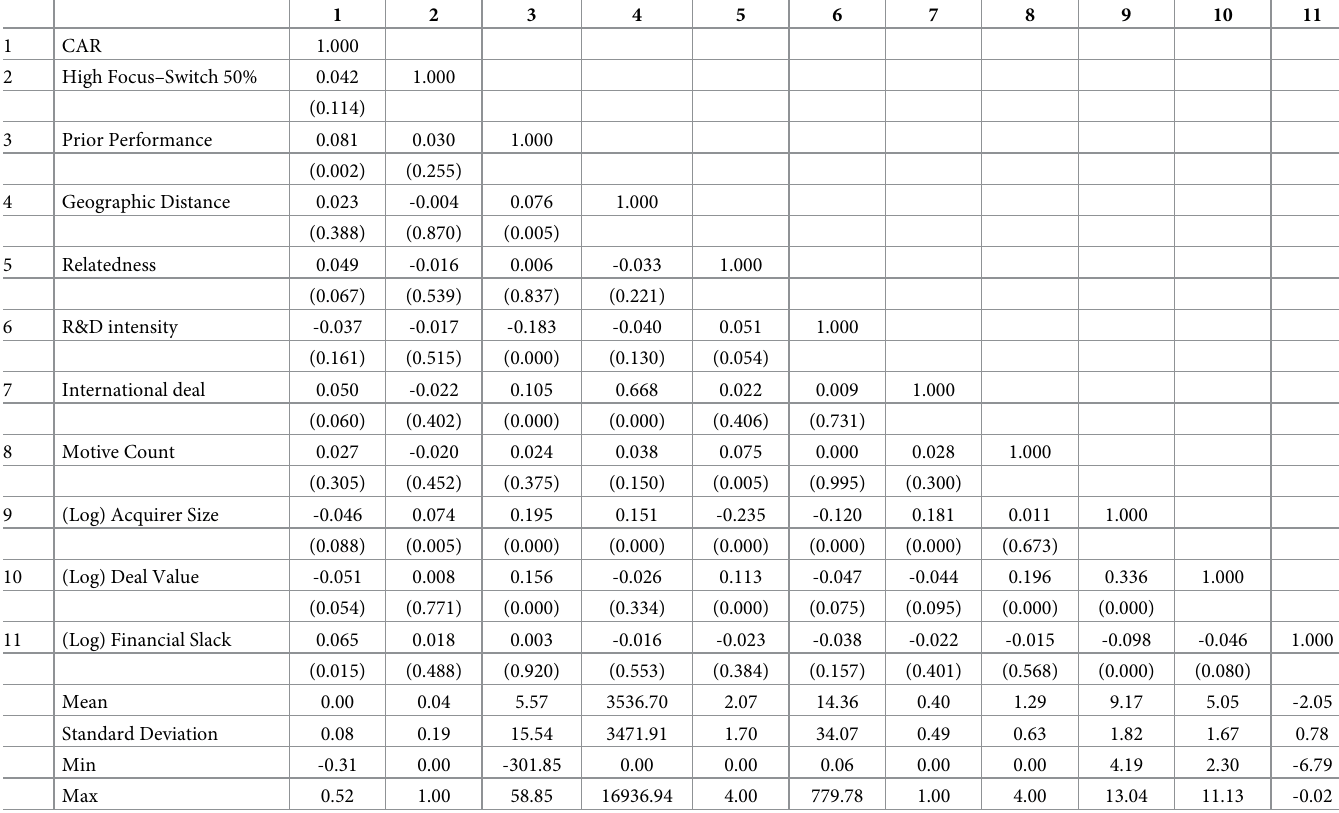
Table 3. Descriptive statistics and